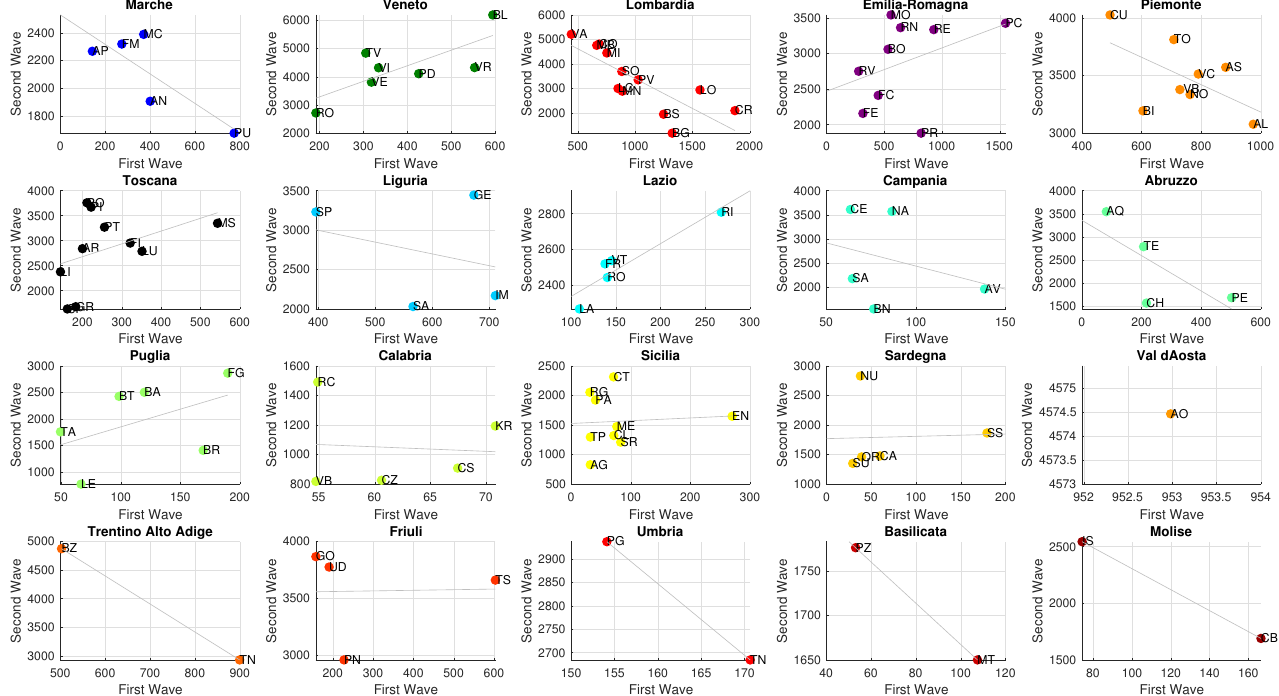
Figure 3. Daily Cases per 100k people in Marche and Lombardia. Note: this figure displays the correlation between intensity of the COVID-19 first wave, measured as cumulative number of daily cases per 100 thousand people between 24 February 2020 and 16 July 2020, and second wave, measured as cumulative number of daily cases per 100 thousand people between 17 July to 28 December for the twenty Italian regions. The solid line is the region-specific regression